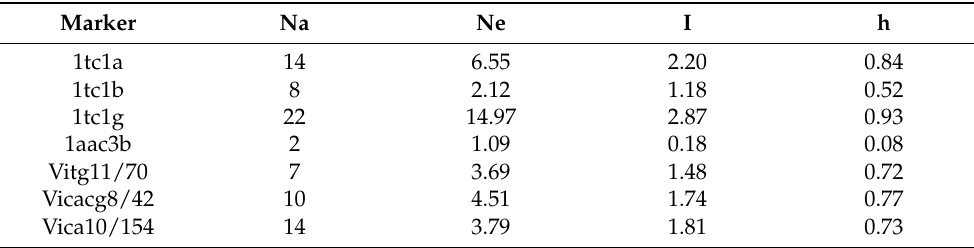
Table 1. Summary statistics of seven SSR markers used for genotyping 66 monosporic V. inaequalis isolates.